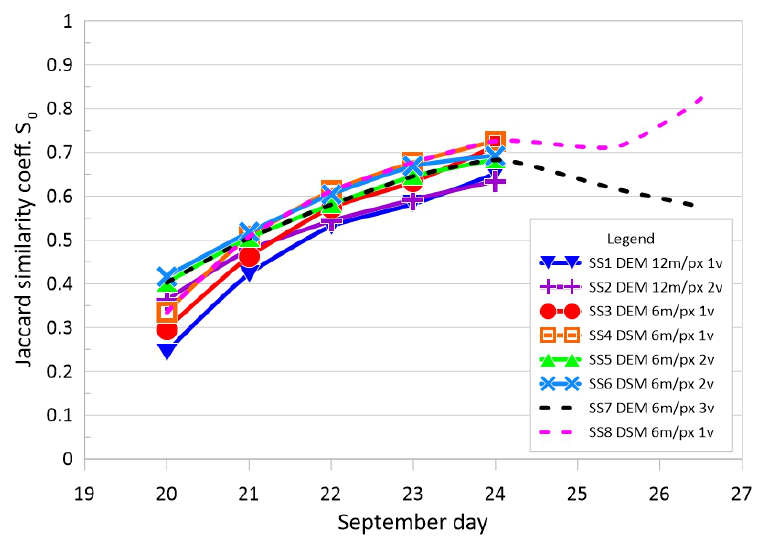
Figure 6. Evolution of Jaccard and maximum distance similarity indices for the simulations carried out in this study (Table